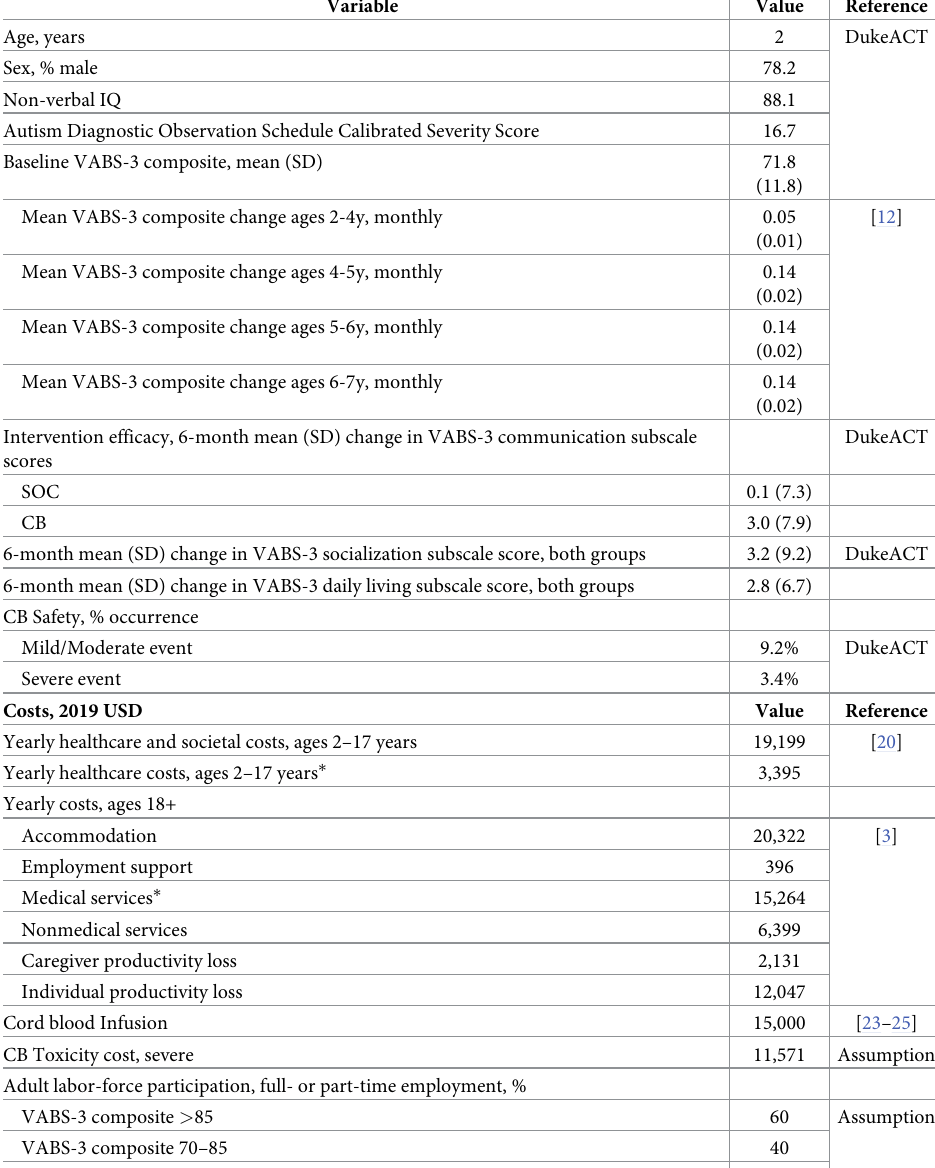
Table 1. Model input